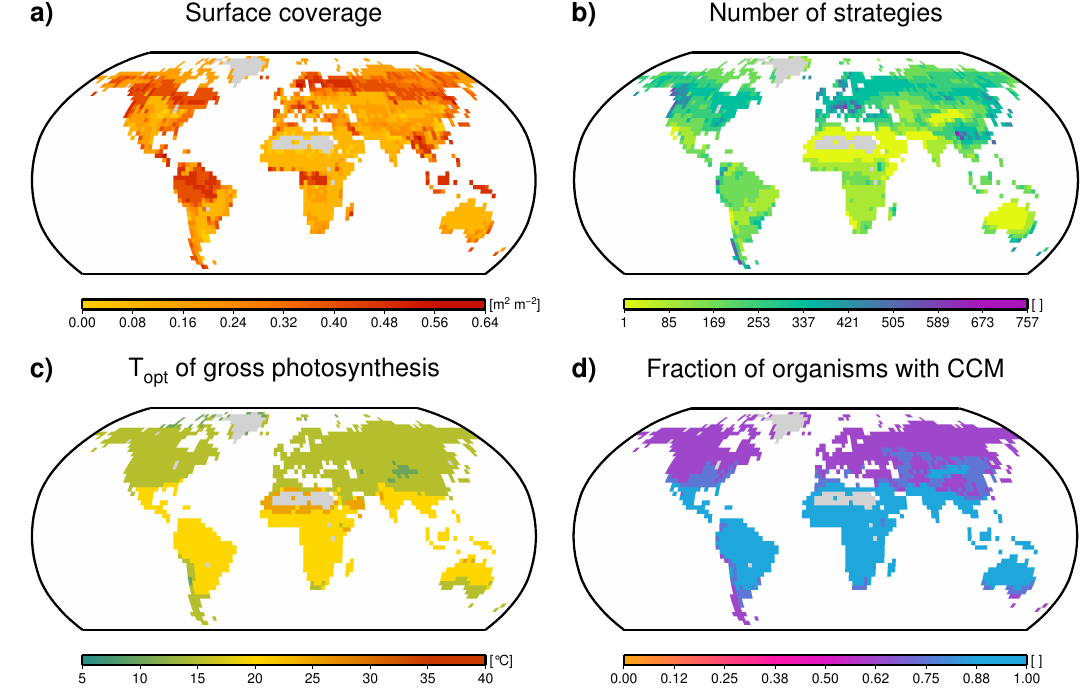
Figure 6: Global maps of model estimates. a) Area covered by lichens and bryophytes per Fig. 6. Global maps of model estimates. (a) Area covered by lichens and bryophytes per m 2 ground. (b) Number of surviving strategies at m 2 ground. b) Number of surviving strategies at the end of a model run. c) Optimum the end of a model run. (c) Optimum temperature of gross photosynthesis of lichens and bryophytes on the ground. (d) Fraction of lichens and bryophytes on the ground with a carbon concentration mechanism (CCM). The estimates are based on time averages of the last 100yr temperature of gross photosynthesis of lichens and bryophytes on the ground. d) Fraction of a 2000yr run with 3000 initial strategies. They correspond to the average-weighting method (see Sect. 2.3). Areas where no strategy has of lichens and bryophytes on the ground with a Carbon Concentration Mechanism (CCM). been able to survive are shaded in The estimates are based on time averages of the last 100 yr of a 2000-yr run with 3000 initial strategies. They correspond to the “average” weighting method (see Sect. 2.3). Areas where no strategy has been able to survive are shaded in grey.